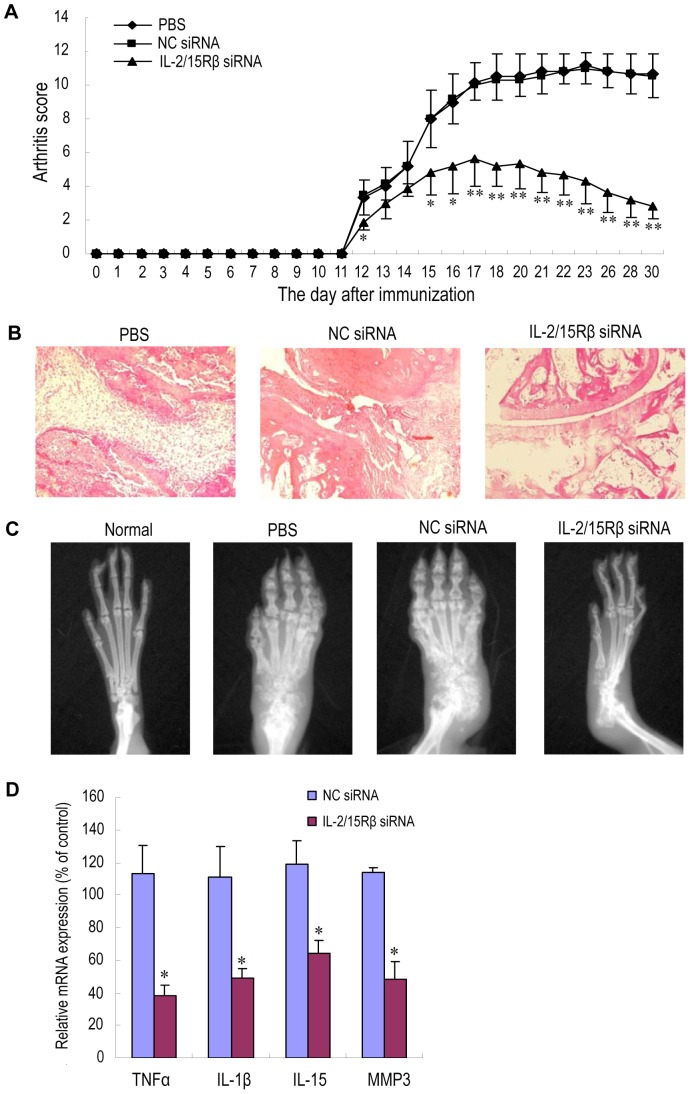
Therapeutic effects of PEI/IL-2/15Rβ siRNA complexes on AA rats.Male Wistar rats (n = 6 per group) were given Freund's complete adjuvant in the left hind footpad on day 0. IL-2/15Rβ siRNA-5 polyplexes were intravenously administered on days 10, 17, and 24 at 0.3 mg siRNA/kg. The rats receiving NC siRNA polyplexes or PBS were served as controls. (A) Arthritis score. Values are the mean and SD. *P<0.05; **P<0.01, versus the PBS group. (B) Representative histopathologies of the right hind ankle joints stained with hematoxylin and eosin (H&E). On day 31, rats were sacrificed and subjected to histopathological examination. Minimal articular inflammation and joint destruction were observed in the group treated with IL-2/15Rβ siRNA polyplexes, whereas PBS- and NC siRNA-treated rats exhibited pronounced synovial hyperplasia, bone damage and joint space narrowing. (C) Representative radiographs of right hind paws (n = 3 per group). On day 31, the rats were anaesthetized and subjected to radiography. Neither paw swelling nor joint damage was observed in normal rats. Severe bone erosion was seen in AA rats treated with either PBS or NC siRNA polyplexes, but the damage was much less in rats treated with IL-2/15Rβ siRNA polyplexes. (D) Effects of IL-2/15Rβ siRNA polyplexes on mRNA expression of inflammatory factors. At the end of the experiment (day 31), RNA was prepared from the right hind ankle joints of AA rats in each group. mRNA levels of each factor were determined by qPCR, normalized against GAPDH, and expressed as percentage of the PBS control. The result is presented as values (the mean and SD) obtained from three different samples randomly selected in each group. *P<0.05, versus PBS control.